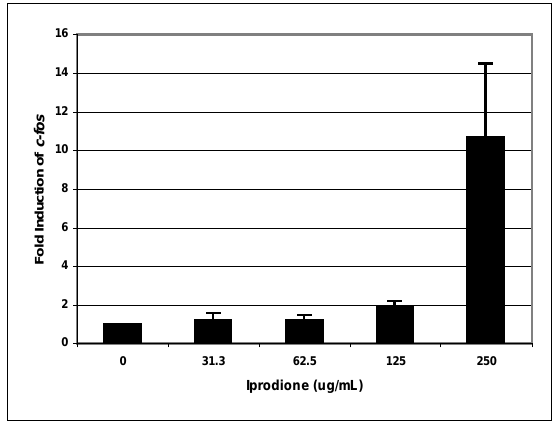
Figure 4 denotes a strong response of the c-fos construct at a concentration of 250 µg/mL. The up- regulation of this construct suggests that iprodione may cause an oncogenic response by binding to the activator protein (AP-1) transcription factor, leading to cell cycle activation of DNA damage, and/or oxidative stress.